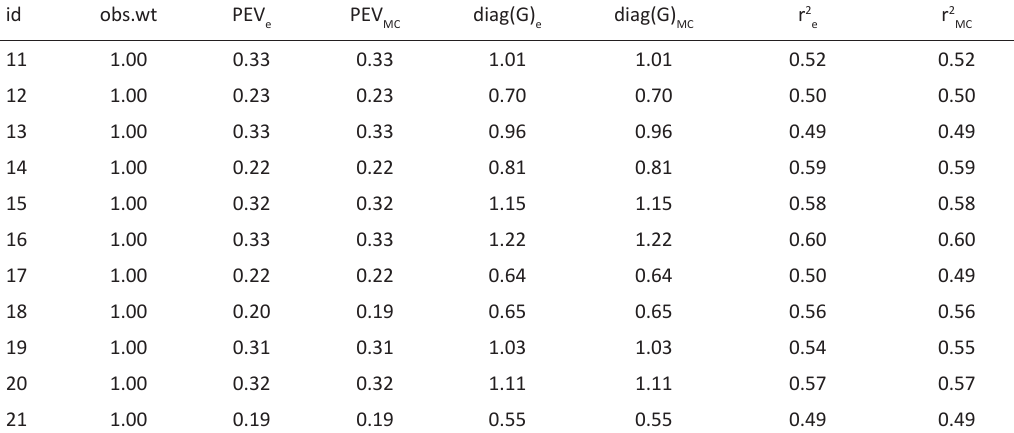
Table 5. Results from snp_blup_rel analysis with a 10% RPG effect for the example case. Columns are for two approaches: exact (e) and MC sampling (MC). The columns are animal ID code (id), weight of observation (obs.wt), prediction error variance (PEV), diagonal of the genomic relationship matrix (diag(G)), and model reliability (r 2 ). id obs.wt